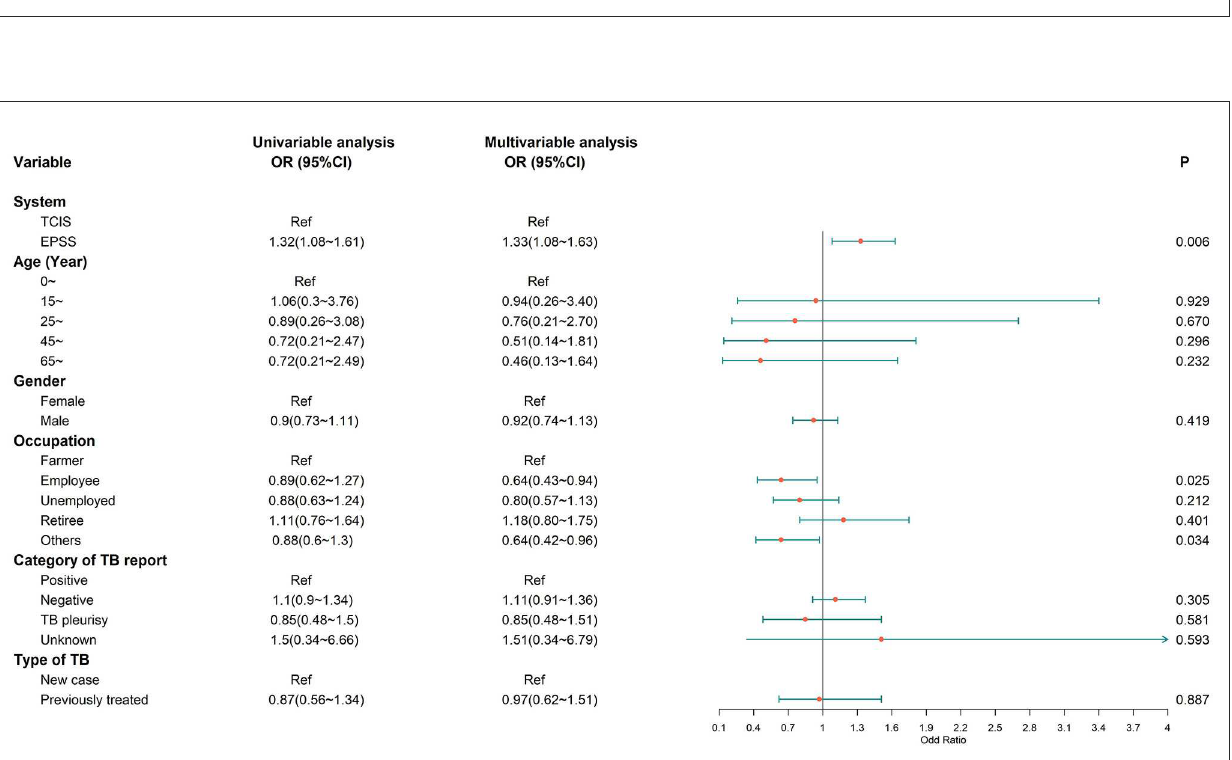
FIGURE3 Multivariate logistic regression analysis on the factors associated with a compliant first follow-up visit. A compliant first follow-up visit, the first visit to the community doctor within 3 days of the start of treatment; OR, odds ratio; CI, confidence interval; model was adjusted for age, gender, occupation, category of TB report, and type of TB.